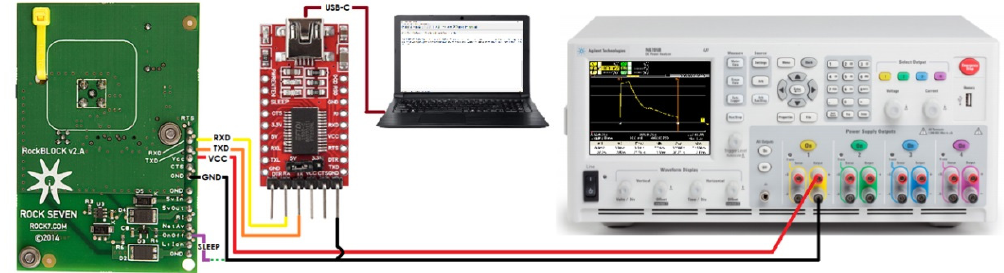
Figure 2. Experimental setup for measuring the current consumption of the RockBLOCK Mk2 Iridium IoT device.